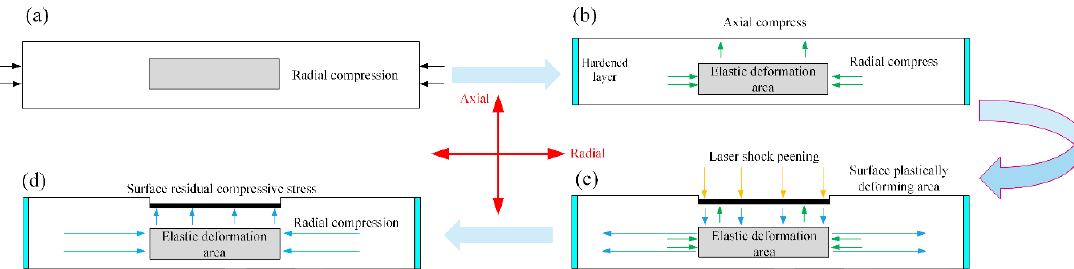
Figure 4. Statistical diagram of surface residual stresses of the four samples.